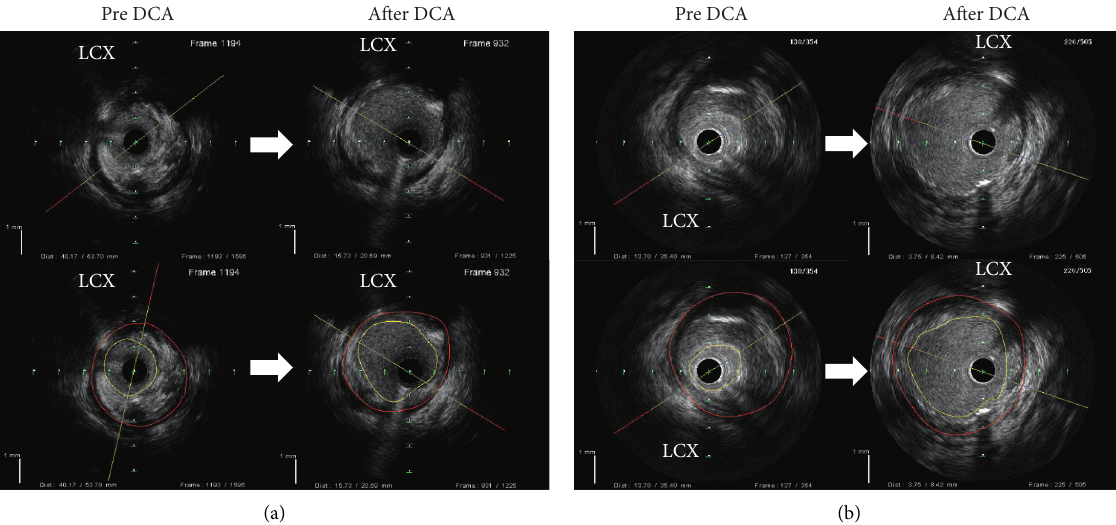
Figure 3: (a) IVUS findings before and after DCA in small vessel lesions. The red line represents the vessel area, and the yellow line represents the lumen area. The lumen area, vessel area, PA, and %PA before DCA were 2.7 mm 2 , 12.6mm 2 , 9.9mm 2 , and 78.5%, re- spectively. The lumen area, vessel area, PA, and %PA after DCA were 8.3 mm 2 , 14.9mm 2 , 6.6mm 2 , and 44.5%, respectively. The Δ lumen area, Δ vessel area, Δ PA, and Δ %PA were 5.6mm 2 , 2.3mm 2 , − 3.3mm 2 , and − 34.0%, respectively. (b) IVUS findings before and after DCA in large vessel lesions. The red line represents the vessel area, and the yellow line represents the lumen area. The lumen area, vessel area, PA, and %PA before DCA were 2.3mm 2 , 14.8mm 2 , 12.6mm 2 , and 84.8%, respectively. The lumen area, vessel area, PA, and %PA after DCA were 10.6mm 2 , 19.8 mm 2 , 9.2mm 2 , and 46.5%, respectively. The Δ lumen area, Δ vessel area, Δ PA, and Δ %PA were 8.3 mm 2 , 5.0mm 2 , − 3.4mm 2 , and − 38.3%,